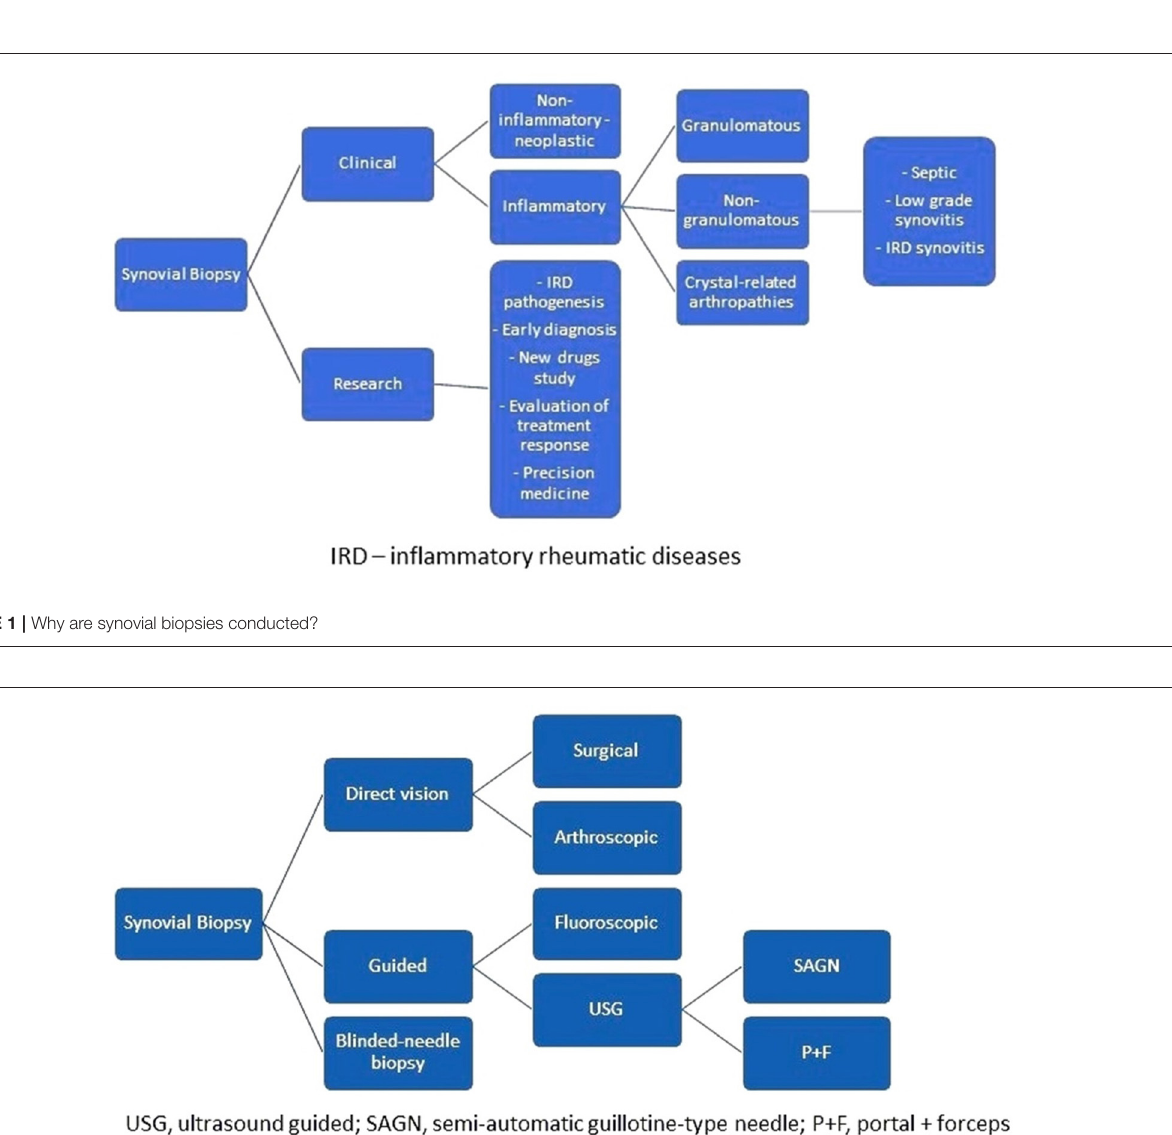
FIGURE 2 | How are synovial biopsies